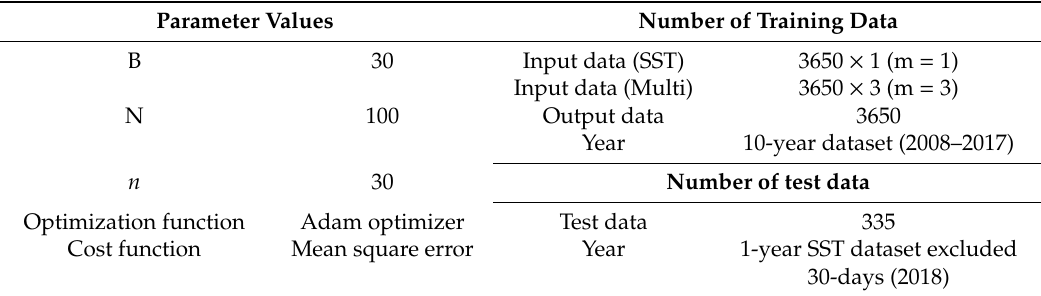
Table 1. Parameter values of the LSTM network and the number of training and test